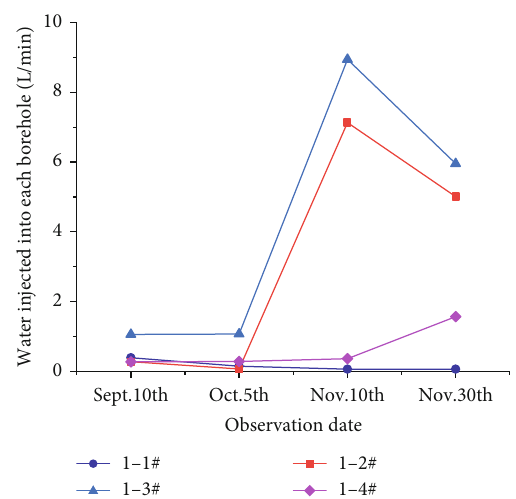
Figure 9: 1# water injection into each borehole at test point.